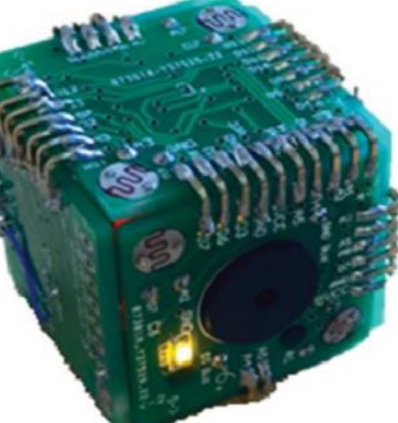
( b ) Figure 14. Prototype of tabletop ( a ), User manipulates with tangible object ( b ) [31]. Martin-Ruiz et al. from the Polytechnic University of Madrid proposed a smart toy for early detection of motoric impairments in childhood (see Figure 15). The goal of smart toy research is to improve the accuracy of traditional assessment using sensors placed in common toys, which then provide experts with additional evidence of decision support systems (DSS). Smart Cube includes a buzzer speaker and LEDs to facilitate child stimu-